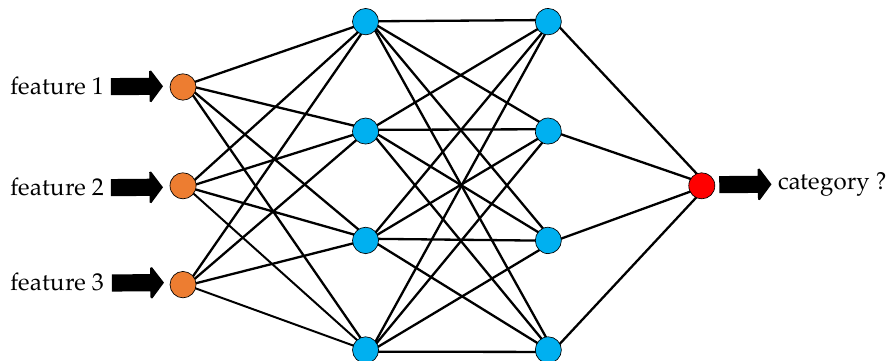
Figure 13. Neural network classification.